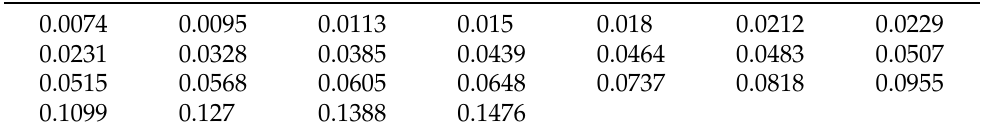
Table 4. The recovery rate of COVID-19 in